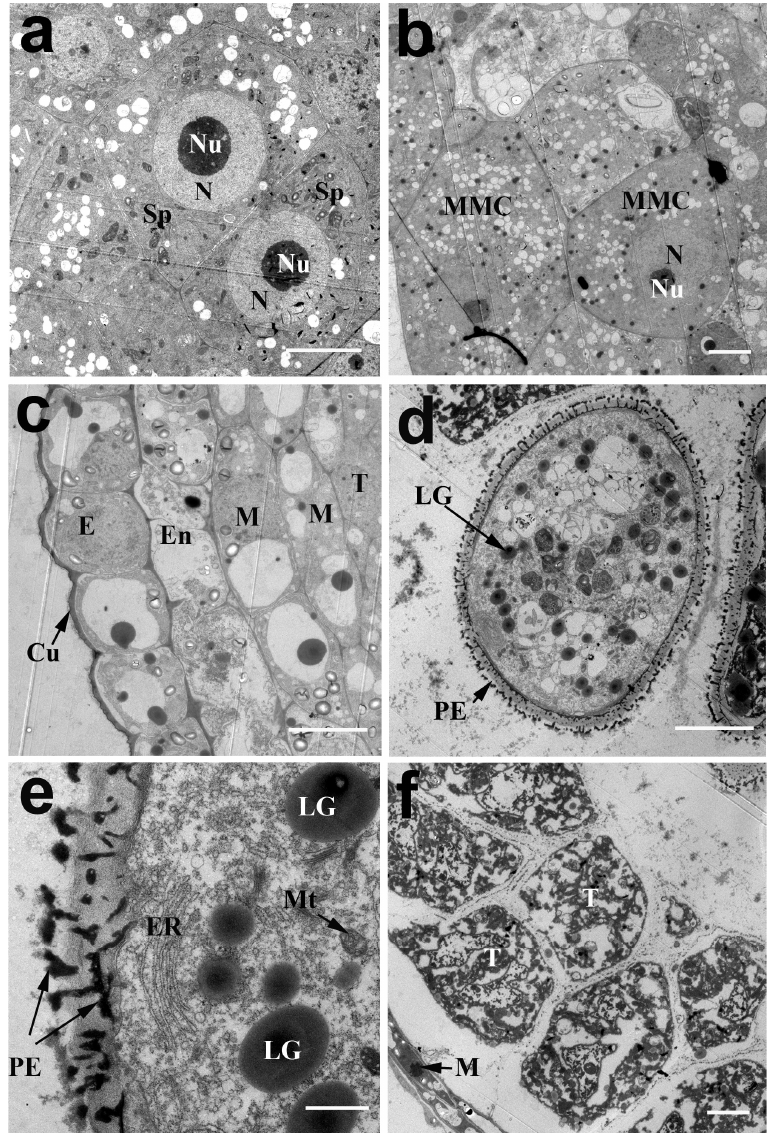
Figure 3. Transmission electron micrographs of cross-sections through anthers of N. nucifera ‘Honghu Hong’. ( a ) The sporogemous cells at the sporogenous cell stage. ( b ) The microspore mother cell at the MMC stage. ( c ) The anther wall comprising the epidermis, endothecium and middle layers at the MMC stage. The arrow indicates the epidermal cuticle. ( d ) The young microspores at the early young microspore stage, the arrows indicate the lipid granule and primexine respectively. ( e ) The magnification image of the young microspore wall at the early young microspore stage, the arrows indicate the primexine and mitochondria, respectively. ( f ) The magnification image of the tapetal cells at the early young microspore stage, the arrow indicates the middle layer. Cu, anther epidermal cuticle; E, epidermis; En, endothecium; ER, endoplasmic reticulum; LG, lipid granule; M, middle layer; MMC, microspore mother cell; Mt, mitochondria; N, nucleus; Nu, nucleolus; PE, primexine; SP, sporogenous cell; T, tapetum. ( a – d , f ) Bar = 5 µ m; ( e ) Bar = 1 µ